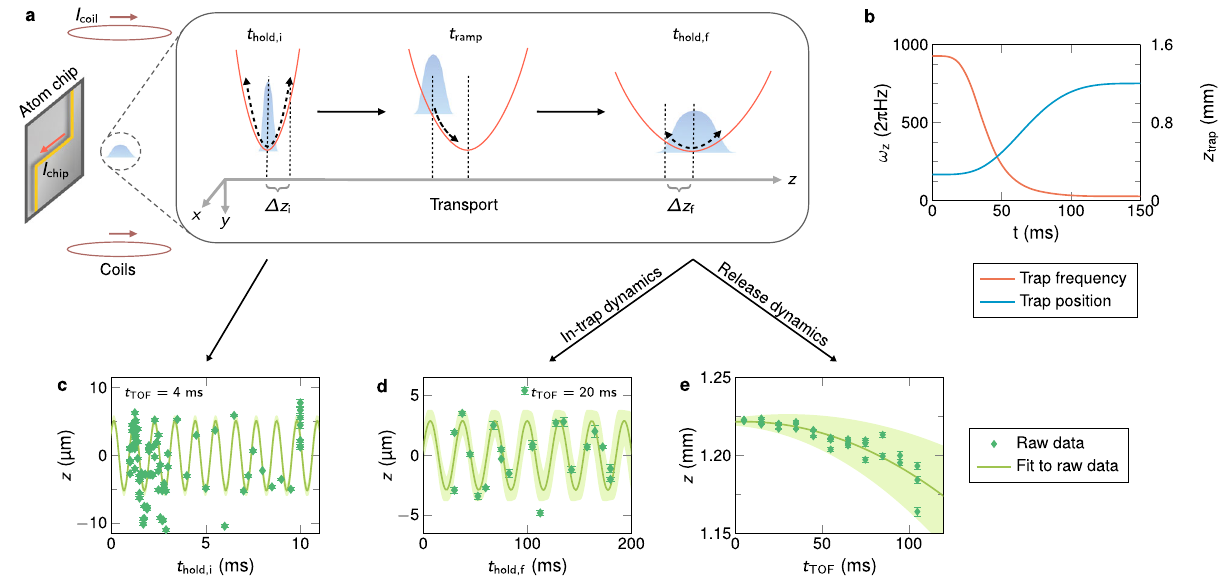
Fig.1|Preciseatomchip-aidedpreparationandcharacterizationofaquantum gas in orbit. a Fast transport in the z -direction away from the atom chip of an initiallytightlycon fi ned,oscillating 87 RbBECtoaweaklycon fi ning fi naltrapwithin a total time t ramp . b Applied ramp of the frequency ω z (red) and trap minimum position z trap (blue) during a typical transport. Exemplary center-of-mass motion (green diamonds) of the BEC after time-of- fl ight t TOF recorded for the initial trap forvaryingholdtimes t hold,i ( c )andafterthetransportforvaryingholdtimes t hold,f ( d )orbyscanningthefreeexpansiontime t TOF afterrelease( e ).Theinitialsloshing ( c )iscausedbytransferfromthefacilitytraptoasimpli fi edtwo-currentramptrap